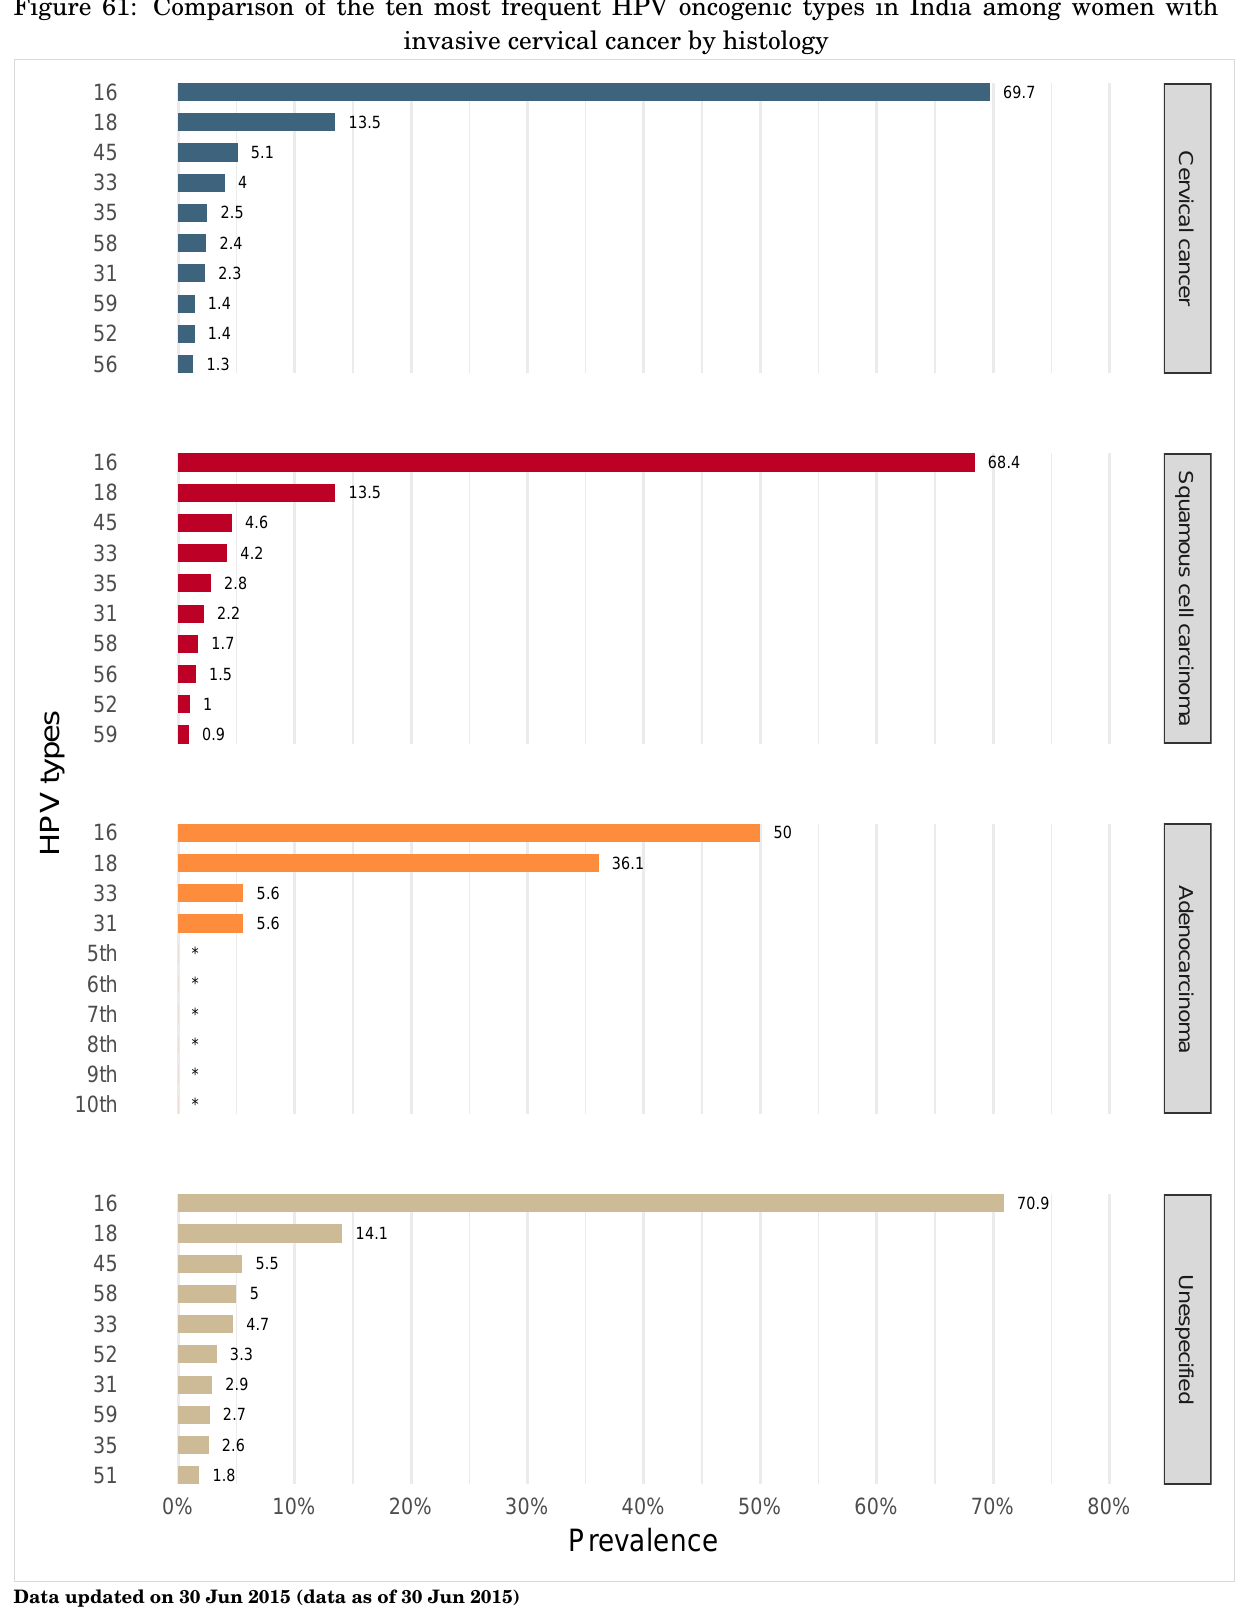
Figure 61: Comparison of the ten most frequent HPV oncogenic types in India among women with invasive cervical cancer by